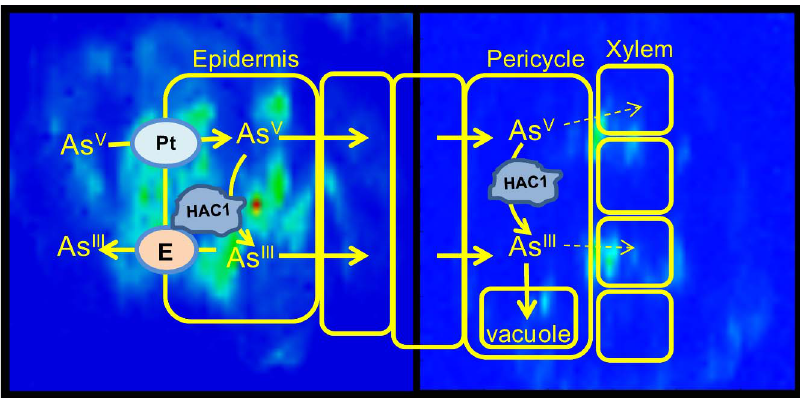
Figure 1. Arsenic is toxic, and its elimination from plants requires it to be converted into arsenite, a form of arsenic that can be released back into the soil from roots. When this fails, arsenic builds up to toxic levels inside the plant.